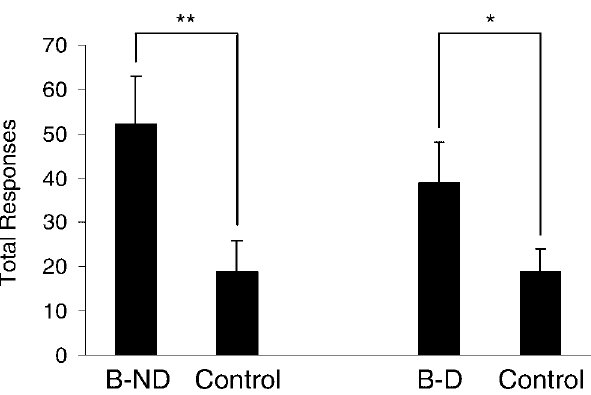
Figure 4. Acquisition of a new response mediated by devaluation- sensitive outcome-specific representations . This graph shows the average total number of responses over two, 30minute sessions on a VR2 schedule. Rats, represented on the left side of the graph, had access to two instrumental responses: one leading to the fully conditioned cue, A, and the other leading to the fully blocked cue, X. Rats represented on the right-side of the graph had access to two responses: one leading to the partially conditioned outcome cue, Y,andtheotherleadingtothefullyblockedcue,X.Ratsrespondedsignificantly more for the conditioned cues, A or Y, than for X. (*, p<0.05).